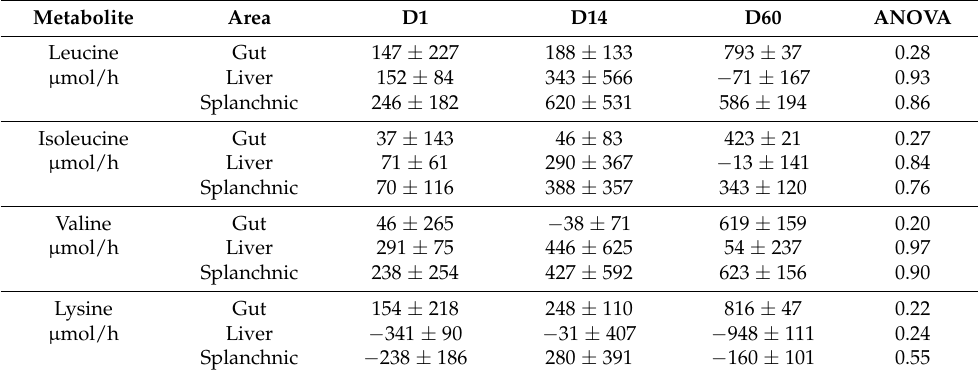
Table 5. Net gut, liver and splanchnic (gut + liver) fluxes of amino acids in the fasted state before (D1) and after 14 days (D14) and 60 days (D60) of adaptation to HFHS